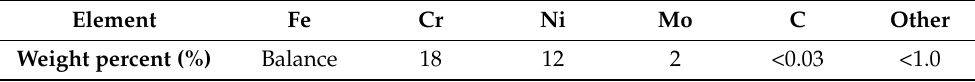
Figure 3. MetcoAdd TM 316L-A powder characterization: ( A ) SEM morphology, ( B ) particle size dis- tribution analysis.